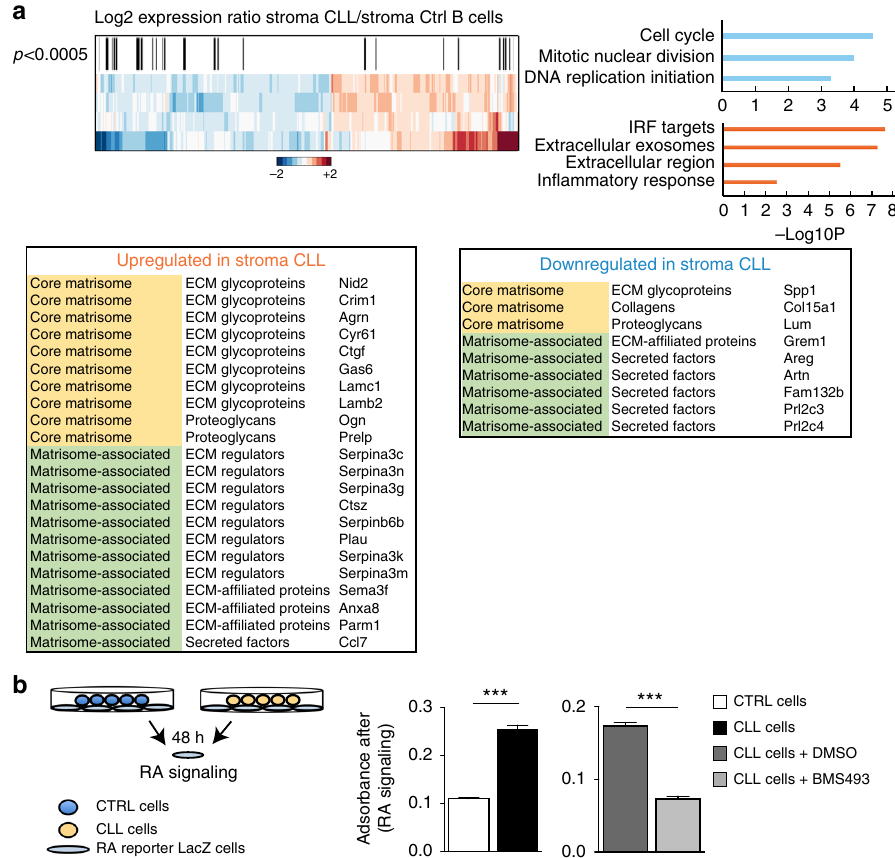
Fig. 1 Leukemic cells induce retinoid-signaling in the stromal microenvironment. a Heat map of deregulated genes and their annotation analysis for the Illumina microarray. Black bars represent genes belonging to the collection of the MatrisomeDB atlas (see lists); enrichment signi fi cance was computed according to the hypergeometric distribution. b Experimental design of RA-reporter cells cultured with murine E μ -TCL1 CLL or control splenic B cells (left). RA-signaling was measured by quantifying the β -gal activity (absorbance after ONPG staining) (left) after co-cultures, and treatments with vehicle (DMSO) or with BMS493 (right). Data are representative of six independent experiments. The mean of triplicates and ±SD are shown, *** p <